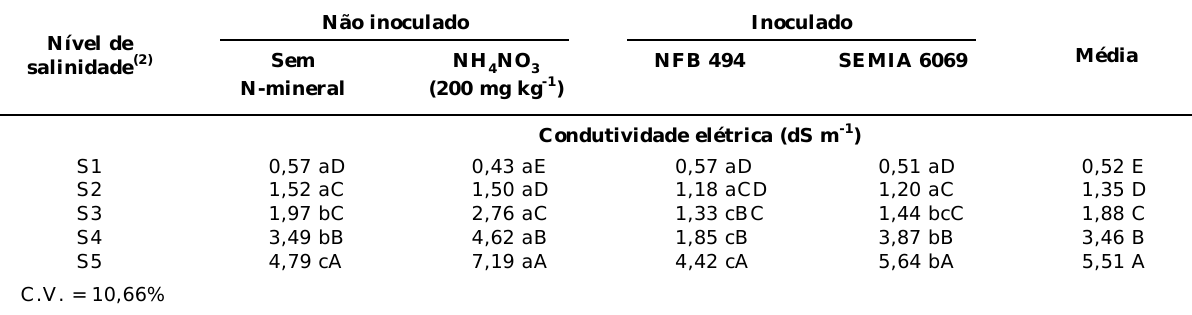
Quadro 5. Efeito da inoculação de R. loti e da aplicação de NH solo Podzólico Vermelho-Amarelo, cultivado com leucena, coletada a 95 dias após o plantio